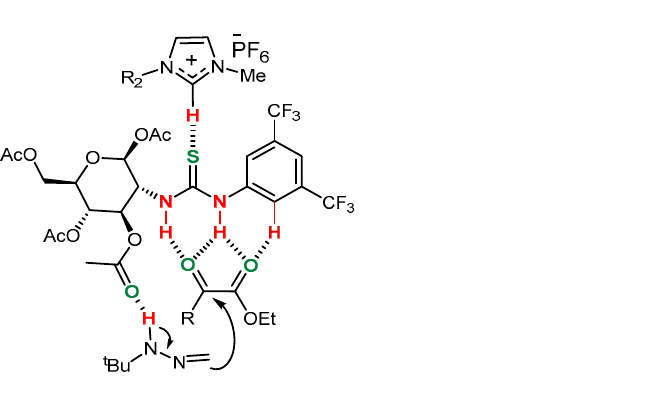
Figure 1. Proposed model for the enhancement of the (thio)urea catalyst II acidity by the interac- tion of imidazolium cation with the (thio)urea moiety. of imidazolium cation with the (thio)urea